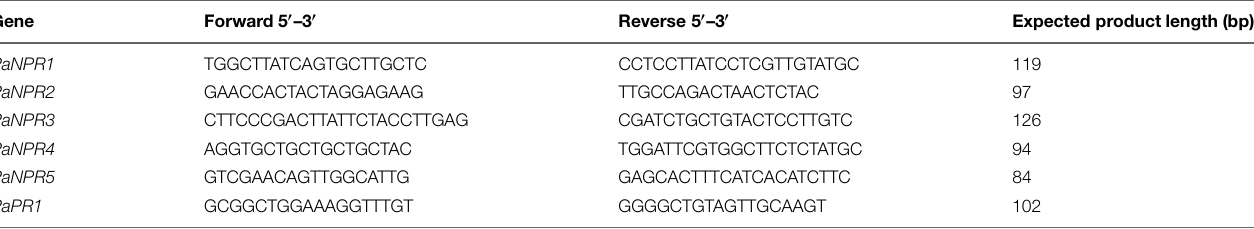
TABLE 2 | Primer sequences used in reverse transcription quantitative PCR